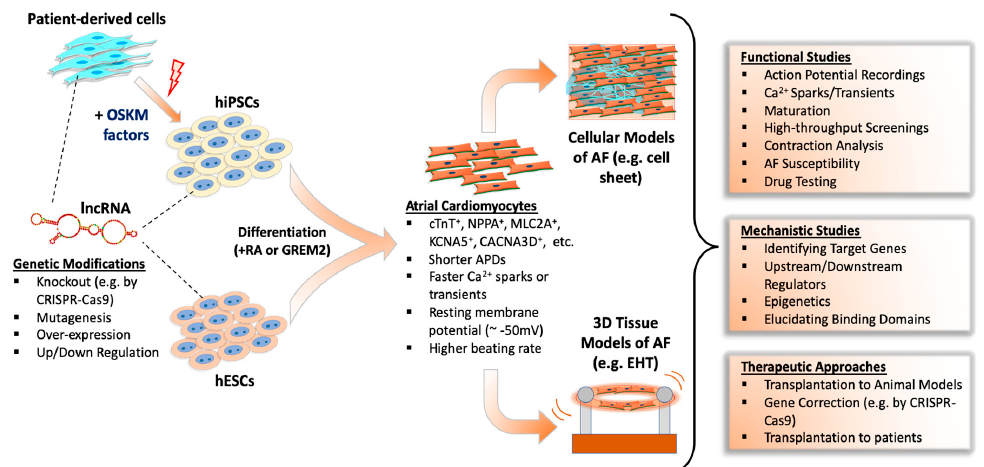
Figure 1. Studying function and mechanism of lncRNAs in human pluripotent stem cell-based atrial fibrillation models.